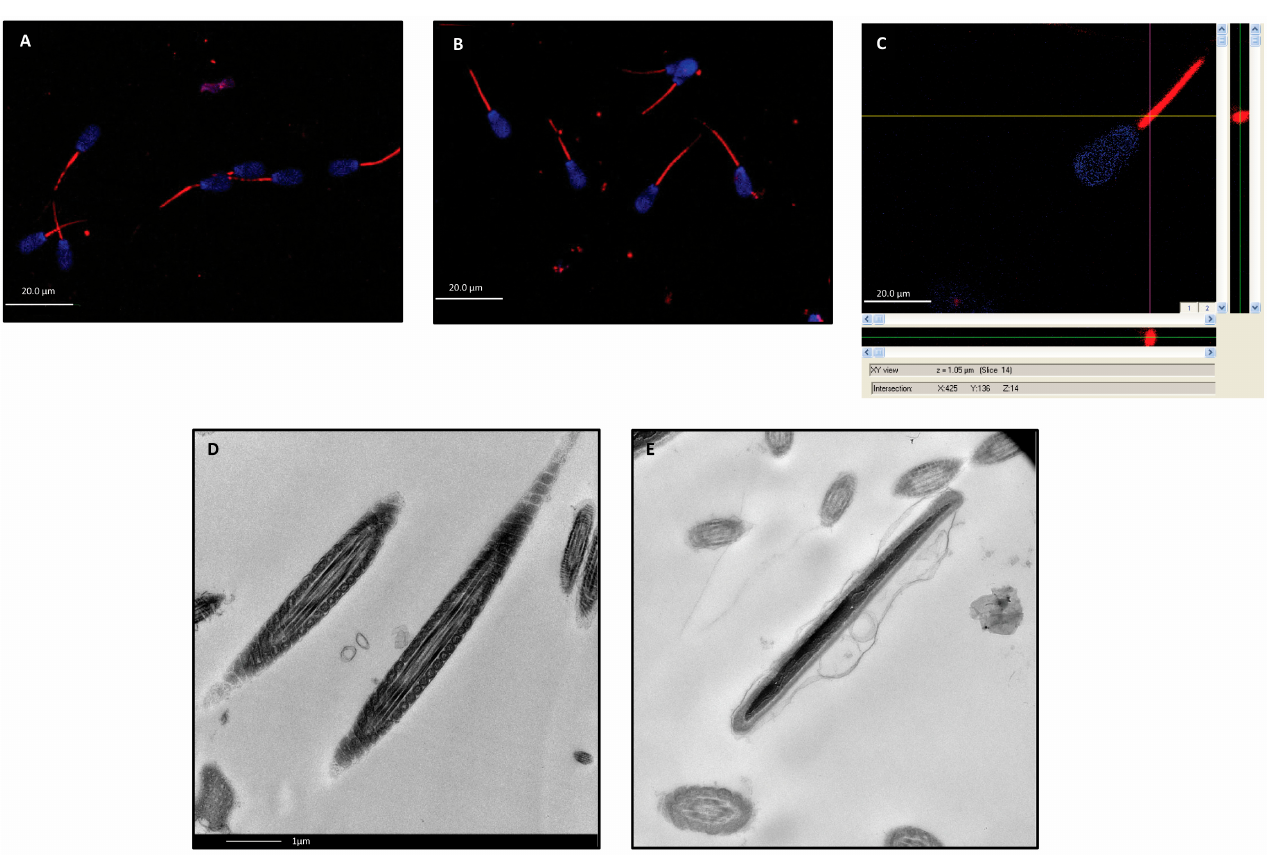
Figure 2. Dose–response curve. ( A ) At 400 × 10 6 EVs/mL, the incorporation was uniform. ( B ) Incor- poration with red dots at lower concentration. ( C ) z-Stack image obtained via confocal microscopy. EVs are included within the tail and not resting on the membrane. ( D ) Electron microscope figure of control spermatozoa incubated in absence of EVs. ( E ) Electron microscope figure of spermatozoa incubated with EVs, which are incorporated in the middle tract. This figure shows an intact sperm membrane (scale bar 1 μ m).